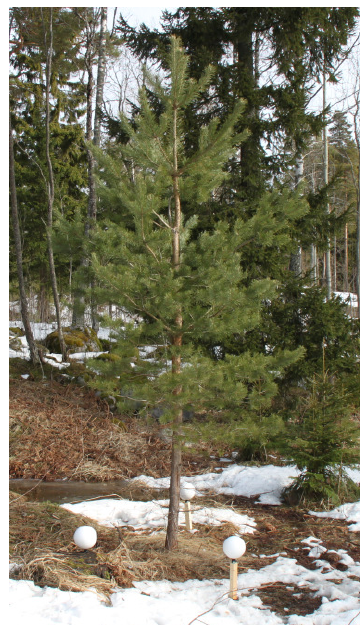
Figure 1. The pine sample before the measurement in April 2013. The white spherical reference targets visible in the image were used for the co-registration of